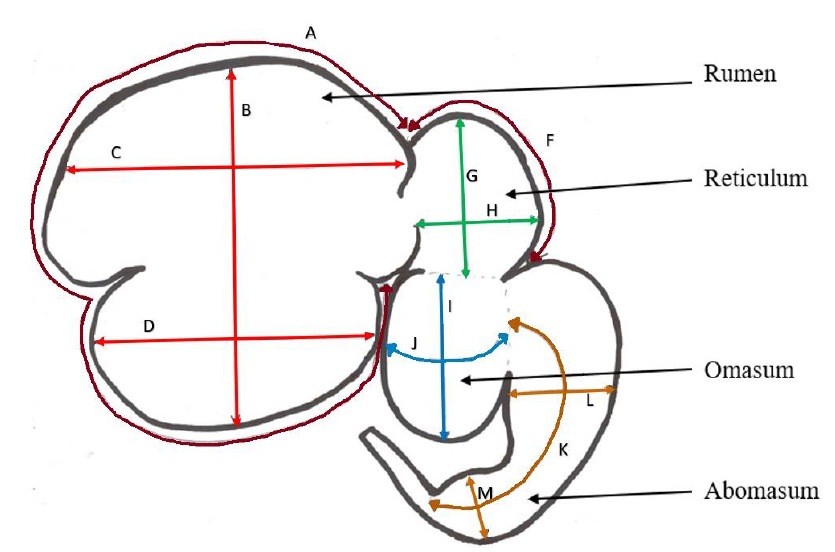
Figure 1. Length, width and circumference measurements of rumen, reticulum, omasum, and abomasum recorded at slaughter (A; circumference of rumen, B; length of rumen, C; width of dorsal rumen, D; width of ventral rumen, F; circumference of reticulum, G; length of reticulum, H; width of reticulum, I; length of omasum, J; circumference of omasum, K; length of abomasum, L; width at proximal end of abomasum, M; width at distal end of abomasum, red, green, blue and brown lines represent measurements recorded for rumen, reticulum, omasum and abomasum, respectively and dark brown lines represent circumference of rumen and reticulum, respectively).